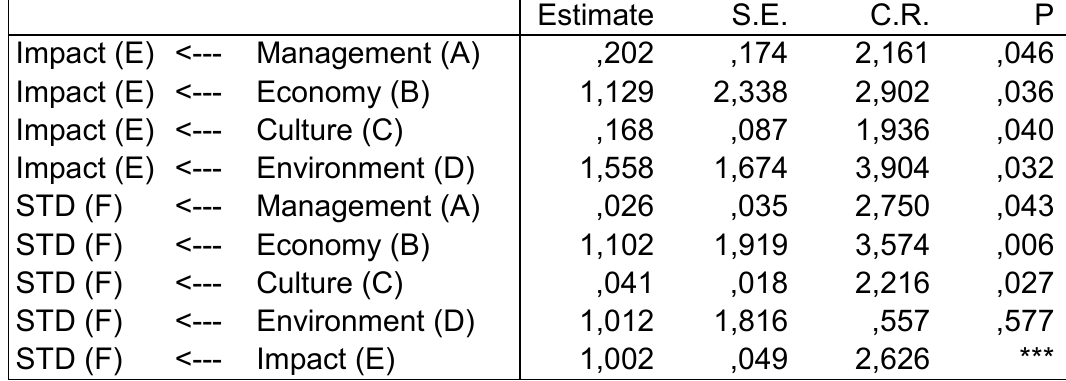
Table 4. Summary of Causality Between Variables